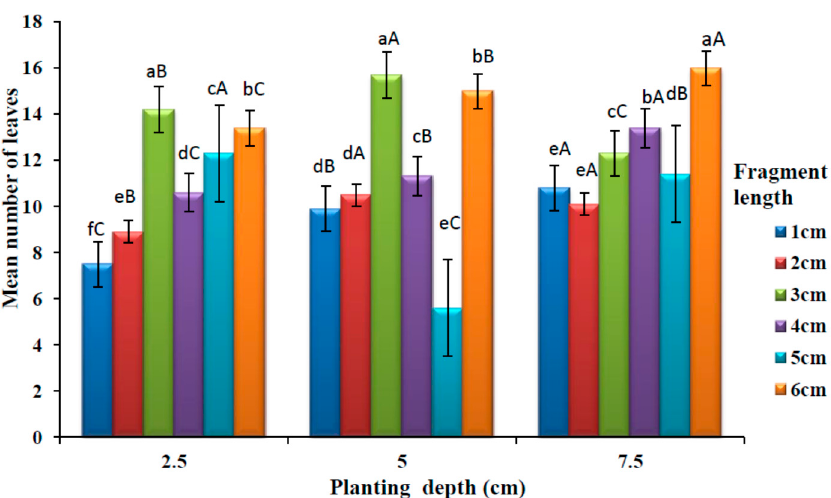
Figure 4. Effects of varying burial depths and fragments lengths of A. amatymbica rhizome on the number of leaves. Bars with different lowercase superscripts (a > b > c > d > e) in the same groups of planting depth are significantly different ( p < 0.05) while bars with different uppercase superscripts (A > B > C) within a fragment length in the different groups of planting depth (2.5, 5 and 7.5 cm)